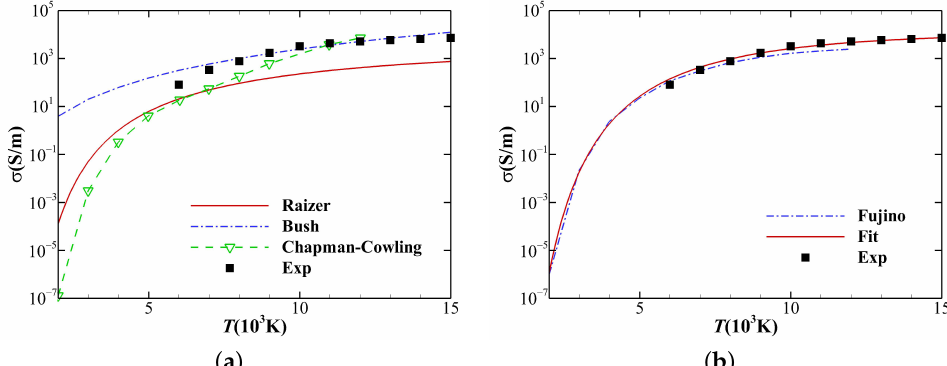
Figure 2. ( a ) Comparison between semi-analytic models and experimental data [34]. ( b ) Comparison between Fujino’s result, Fit model and experimental